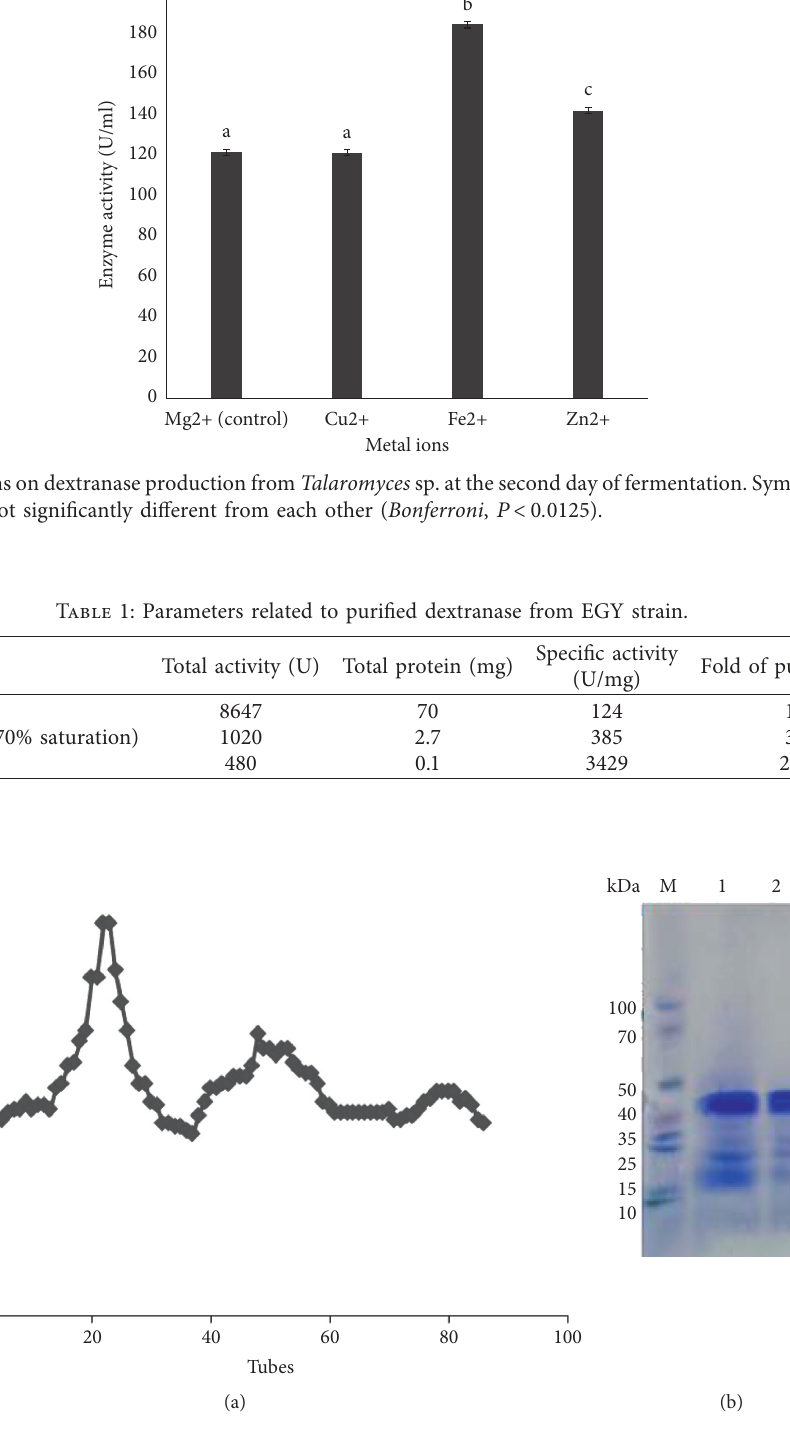
Figure 7: Purification of dextranase by Sephadex G-100 chromatography. (a) The protein concentrations of different tube fractions eluted from the Sephadex G-100 column. (b) Analysis of purified dextranase (tube fractions 19–22) by 12% SDS-PAGE. Lane M: protein